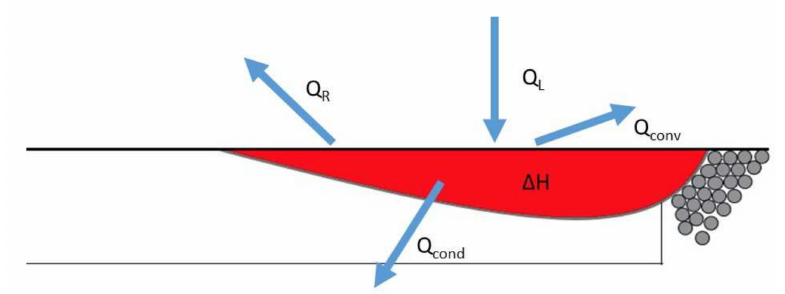
Figure 9. Energy balance for the melt pool [4].